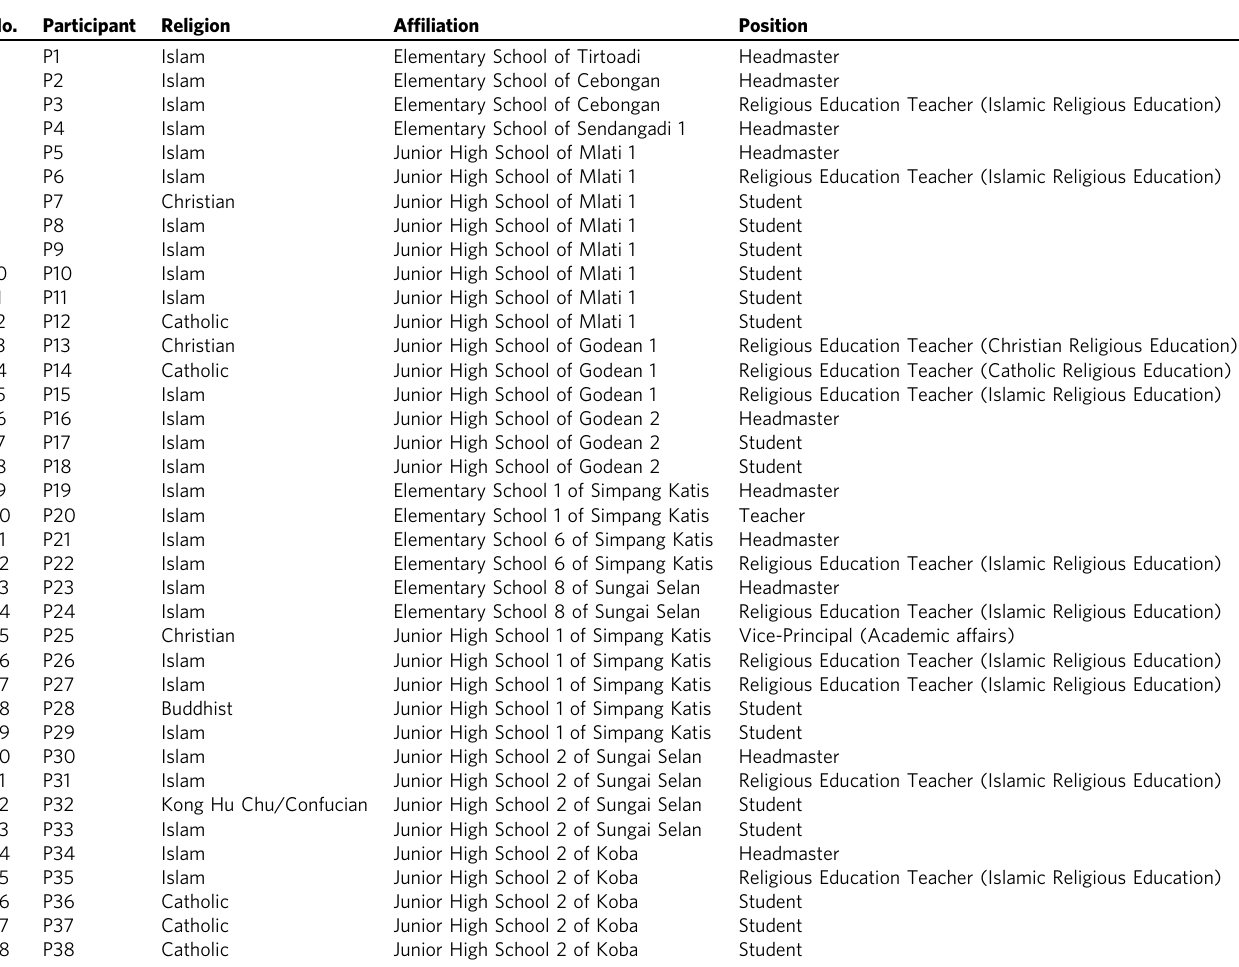
Table 4 List of